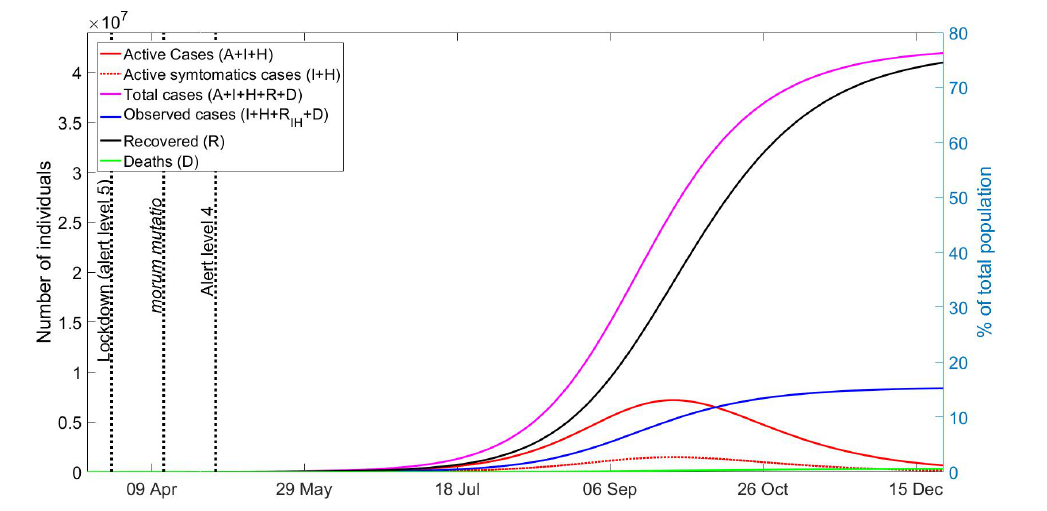
Fig. 7. Long term dynamics with ρ = 0 .